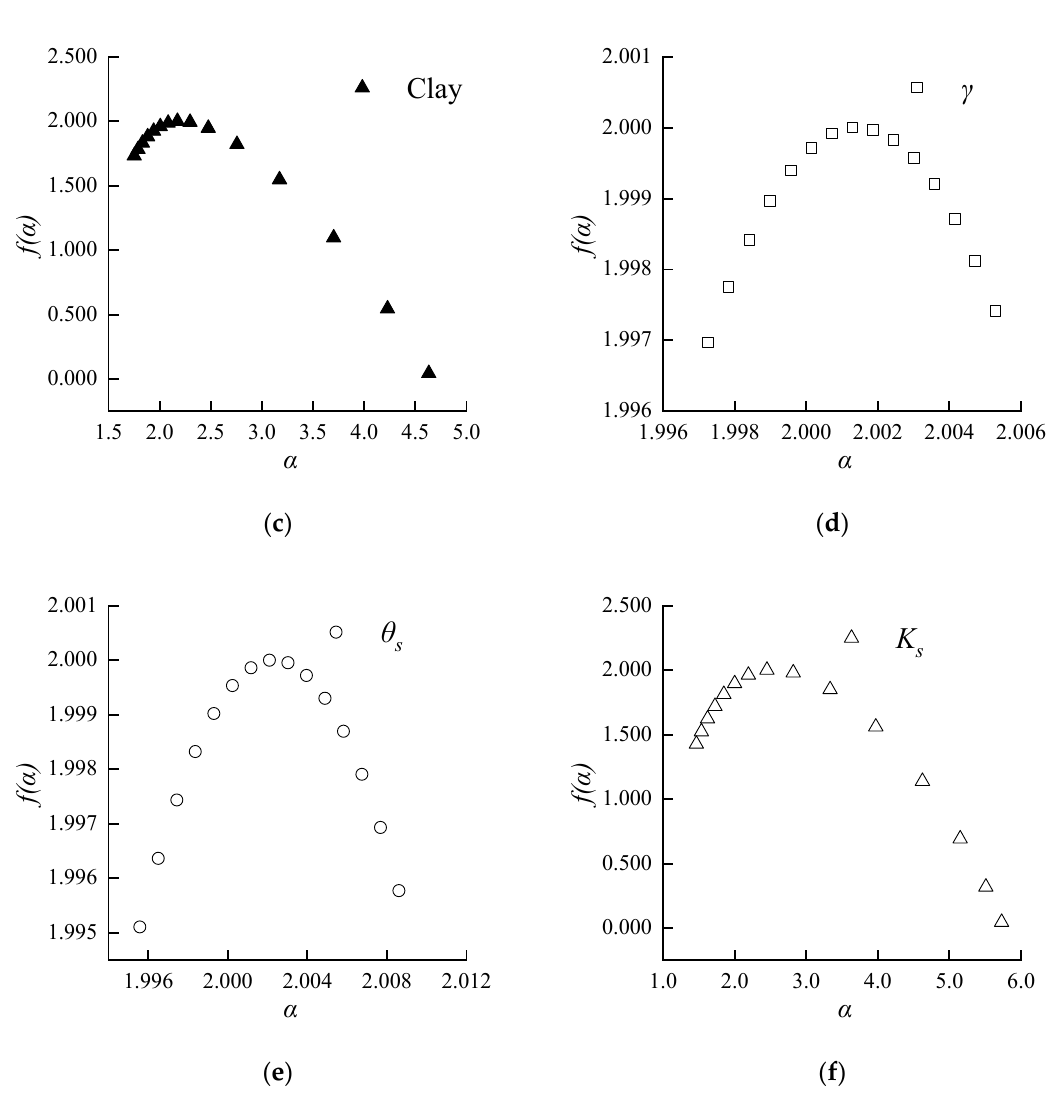
Figure 5. Multifractal spectrum curve of soil properties in the study area. f ( α )—the singularity spectrum.